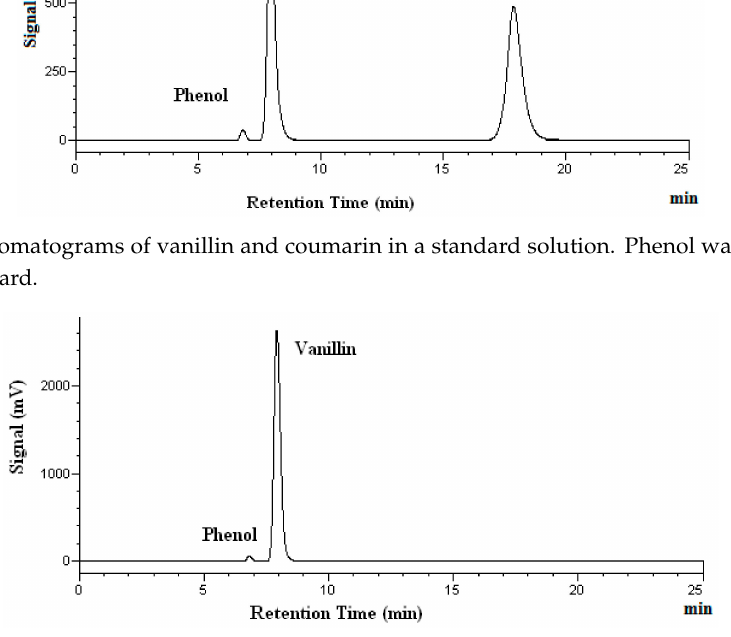
Figure 3. Chromatograms of vanillin after heating at 200 ◦ C. Phenol was used as the internal standard. Table 1. Average percent recovery of vanillin obtained at di ff erent temperatures after heating.